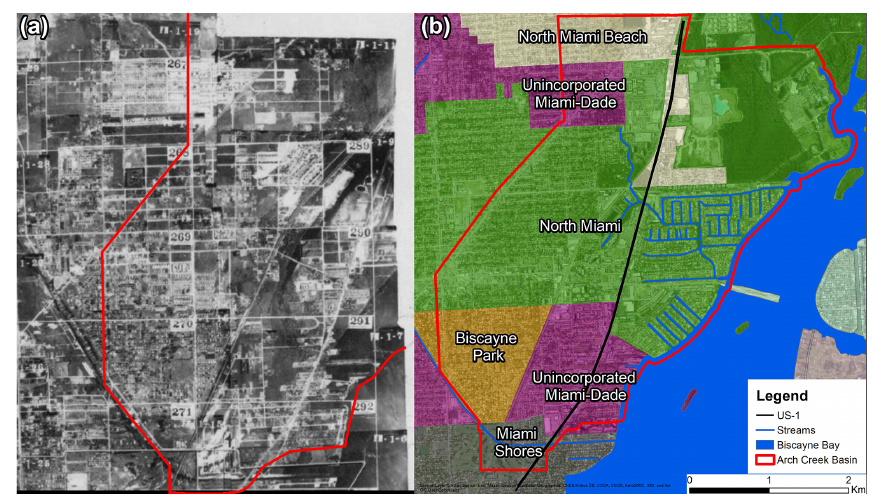
Figure 2. Aerial photography that compares the historical (1948) and current urbanized environment in the study area. (a) Major civil and drainage works contributed to the rapid urbanization of the Arch Creek Basin; (b) municipality map, including North Miami, Biscayne Park,